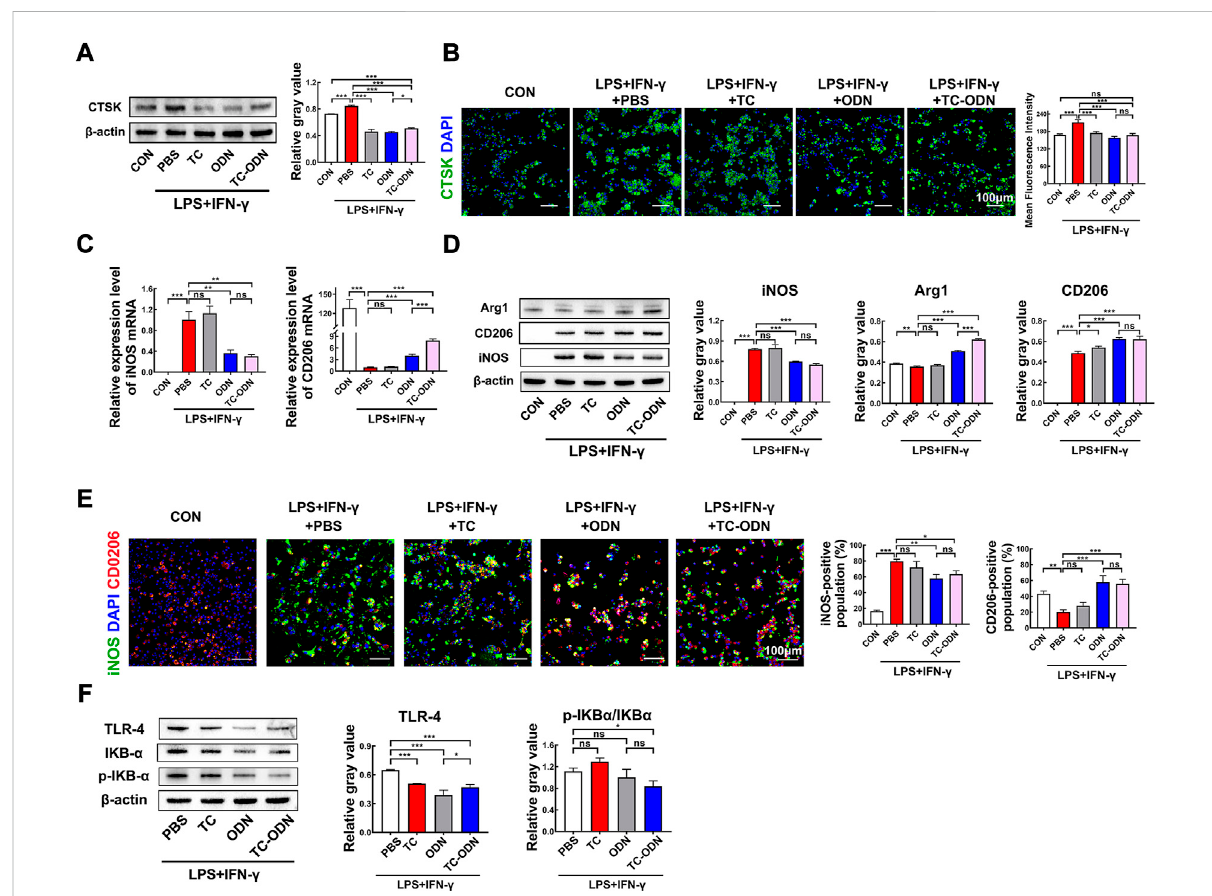
FIGURE 2 Regulation of macrophage polarization by TC-ODN to inhibit local in fl ammation. (A) Western blot analysis of the protein levels of CTSK in macrophages with different treatments and the semi-quantitative analysis in each group ( n = 3). (B) Representative images of immuno fl uorescence stainingtodetecttheexpressionofCTSKinmacrophagesandthemean fl uorescenceintensity( n =3). (C) RT-PCRanalysisoftheexpressionofiNOS and CD206 in macrophages after different treatments ( n = 3). (D) Western blot analysis of phenotype markers in macrophages under the in fl ammatory medium system after different treatments ( n = 3). pro-in fl ammatory macrophage ’ s marker, iNOS; anti-in fl ammatory macrophage ’ s markers,CD206andArg1. (E) Representative fl uorescenceimagesofthemacrophagesphenotypesafterdifferenttreatments( n =3). (F) Westernblot analysisoftheproteinlevelsofTLR-4,IKB α ,andp-IKB α ,after30 minofincubationwiththein fl ammatorymediumsystem( n =3).Dataarepresented as means ± SD. * p < 0.05, ** p < 0.01 and *** p < 0.001 by one-way